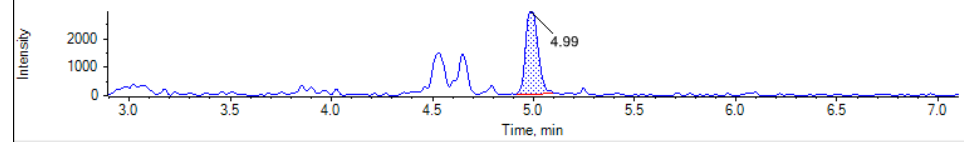
Figure 8. Chromatogram of pistachio kernel sample contaminated with Aflatoxin B1 (AFB1). AFB2 was detect in another sample at 0.73 μg/ kg, lower than ML established for the sum of AFB1, AFB2, AFG1 and AFG2 (4 μ g/kg). Similar results are obtained by Liao et al. [55]. which detected in one out of ten pistachio samples at 0.9 μg/ Kg of AFB2 In this study, pistachio shells were analyzed and in two samples AFB2 was quantified (0.53 and 0.56 μg/ kg).